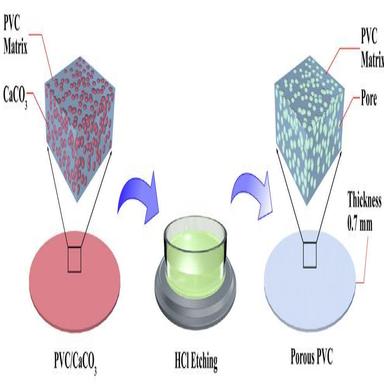
Schematic diagram of sample preparation by chemical etching.